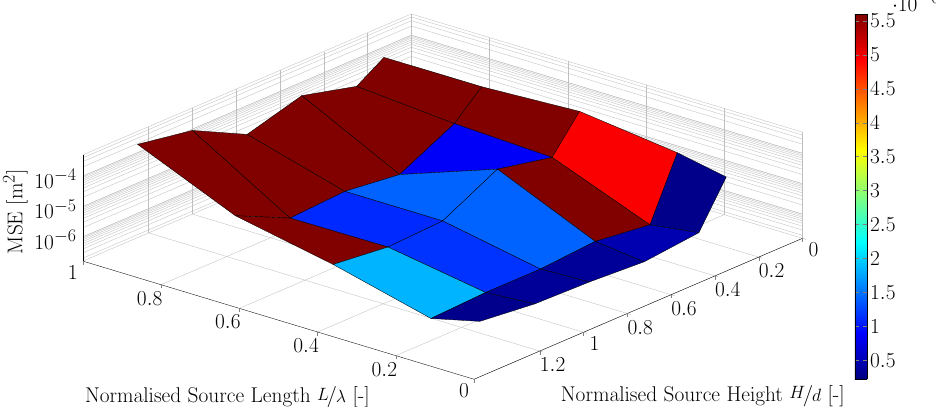
Figure 6. Deep water case: minimal error (2.8